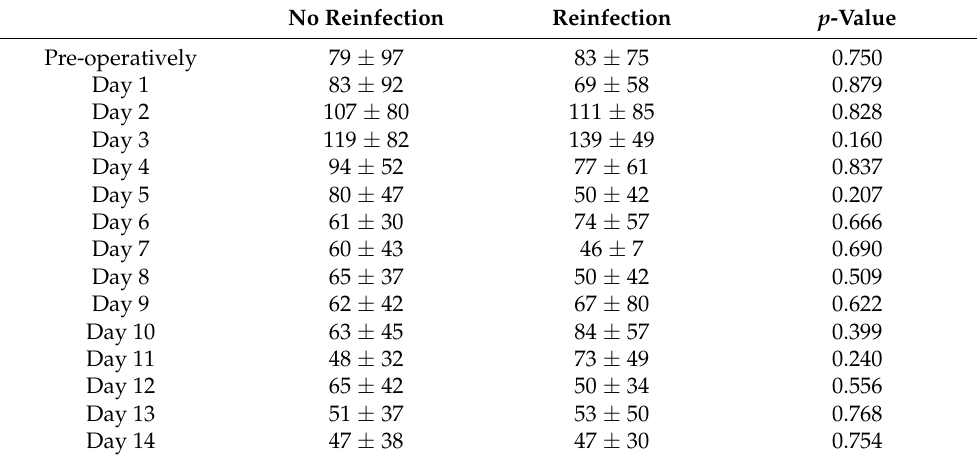
Table 4. Mean CRP values with standard deviation the day before and days 1–14 after the first stage of TSR surgery (in